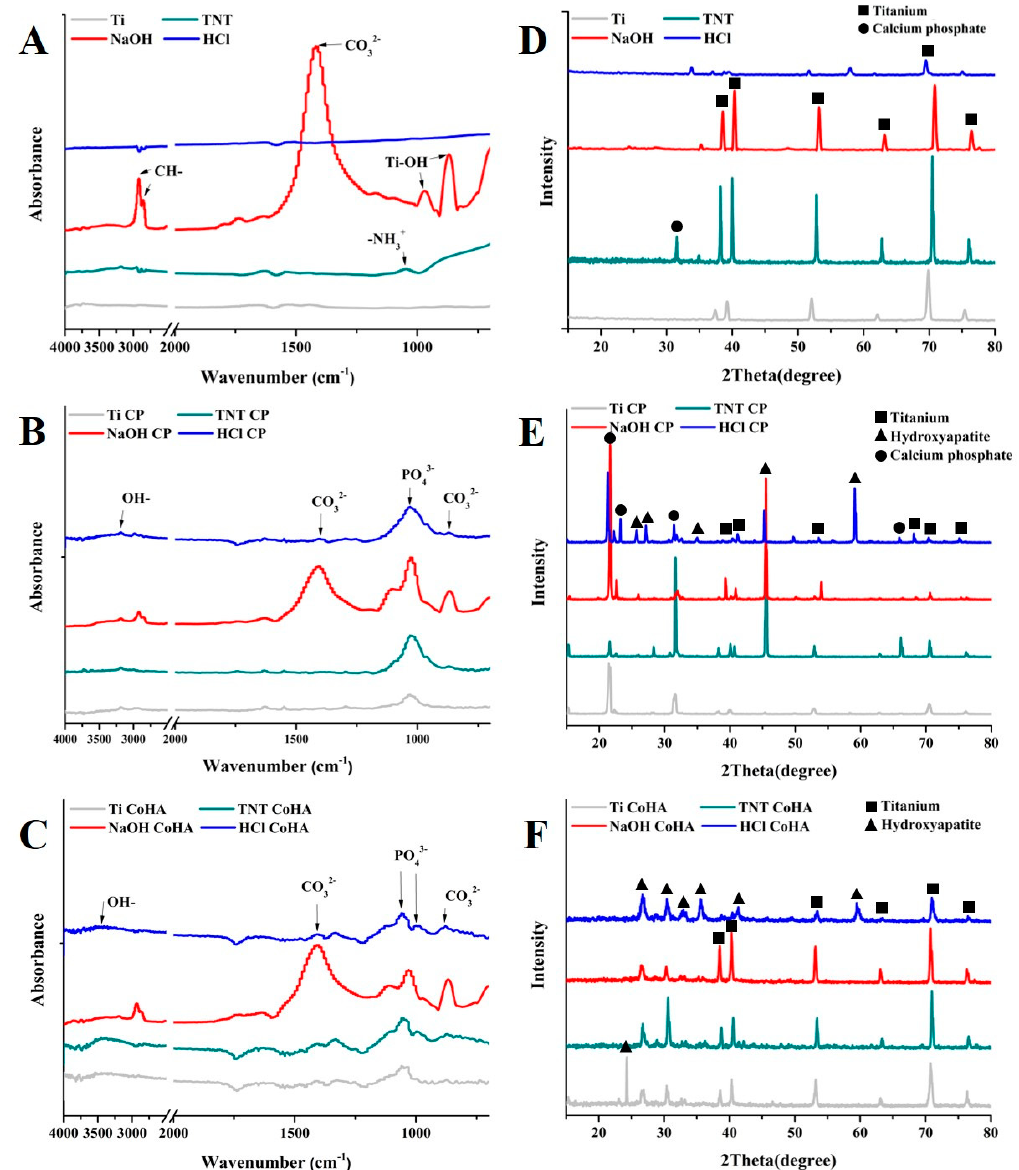
Figure 5. The characteristics of the titanium sheet with different surface treatments and samples after LAB treatments. ( A – C ) FTIR spectra obtained from original, LAB CaP solution and LAB CoHA solution. ( D – F ) XRD patterns of the original, LAB CaP solution, and LAB CoHA solution.